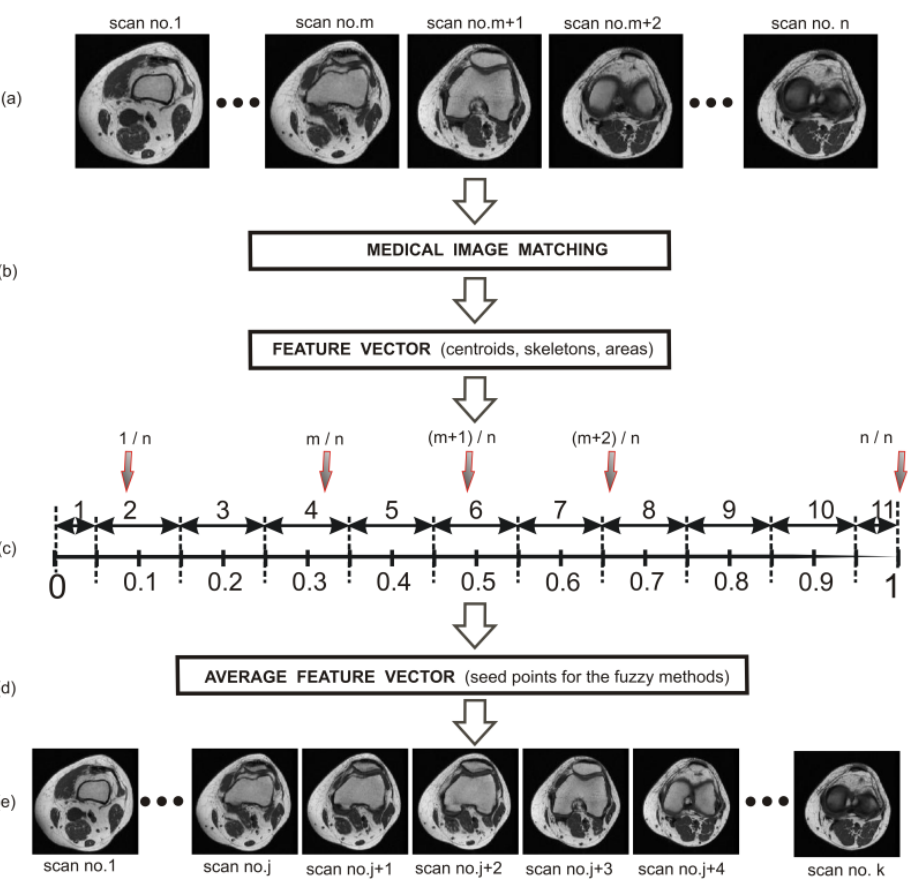
Figure 1. Block diagram: ( a ) Teaching group, ( b ) Automated medical image-matching, ( c ) Determin- ing diagram of the average feature vector, ( d ) Average feature vector, and ( e ) Testing